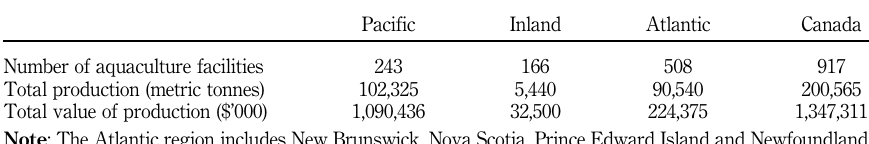
Table II. Number of aquaculture sites in Canada by region with corresponding production and farm gate